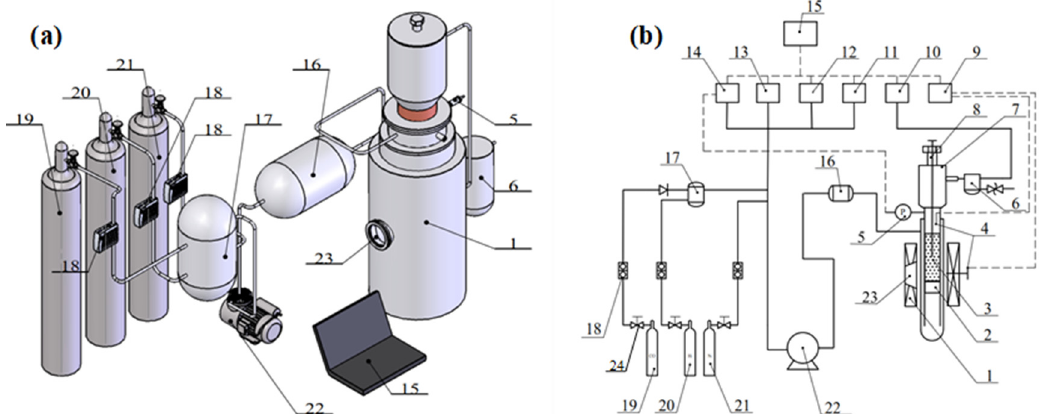
Figure 3. Experimental setup. ( a ) Fluidized bed. ( b ) Reactor. Reproduced with permission from 111 Qiyan Xu, Molecules ; published by MDPI, 2020. 1. Gas mixing and preheating chamber. 2. Gas mixing hole. 3. Fluidized bed. 4. K-type thermal